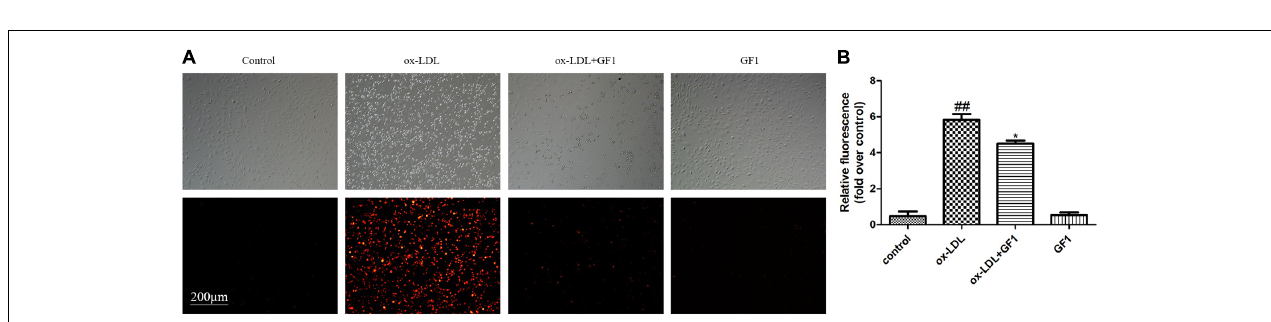
FIGURE 4 | Ginsenoside F1 prevented ox-LDL-induced HUVECs inflammatory injury. (A) Effects of different concentration and time of ox-LDL on HUVECs viability. (B) Effects of GF1 on ox-LDL-induced HUVECs viability. HUVECs were pretreated with the indicated doses (1, 4, and 16 µ M) of GF1 for 24 h before exposure to 70 µ g/ml ox-LDL for another 24 h. Cell viability was measured by the MTT assay. (C) Effects of GF1 on the viability of HUVECs. Cells were incubated with the indicated doses (1, 4, and 16 µ M) of GF1 for 24 h. Cell viability was measured by the MTT assay. (D) HUVECs were pretreated with GF1 (16 µ M) for 24 h and ox-LDL incubation for 24 h. Proteins of the supernatant related to the inflammatory factors were analyzed using human inflammation antibody array. All of the results are expressed as the mean ± SD of three independent experiments. ## p < 0.01, vs. control group; ∗ p < 0.05, ∗∗ p < 0.01 vs. ox-LDL group, NG means no significance.